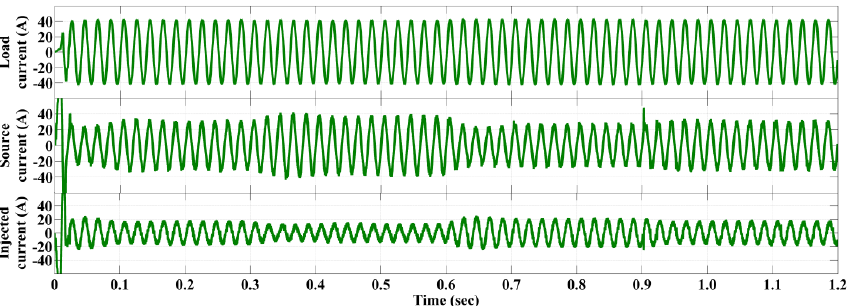
Figure 7. Simulation results with linear load only: source current before compensation, source current after compensation and injection current from shunt APF (top to bottom).